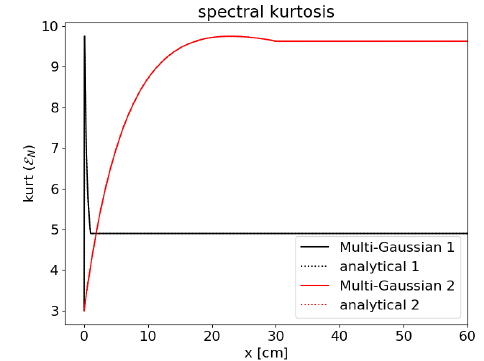
Figure 5. Evolution of the spectral kurtosis kurt( E N ) of the beam along the propagation axis x = τ . Comparison of the multi- Gaussian solution (26) and the analytical reference (10) for two sets of fluctuation parameters. Parameters cf. fig.